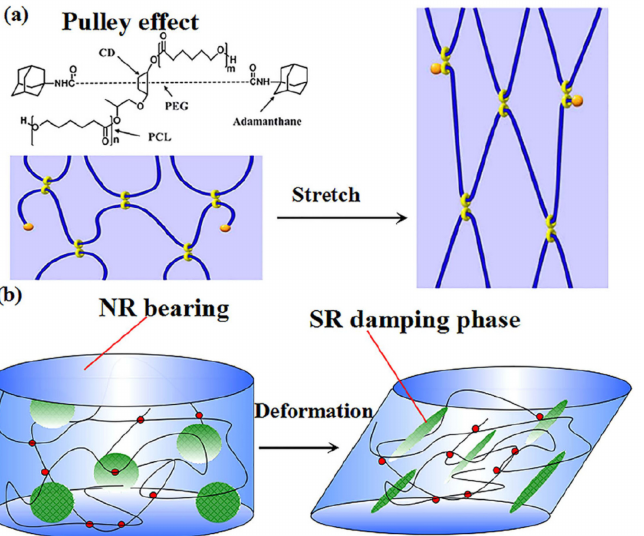
Figure 13. ( a ) Illustration of “Pulley effect” of slide-ring materials and ( b ) design concept of high-damping natural rubber/slide-ring composites [48].